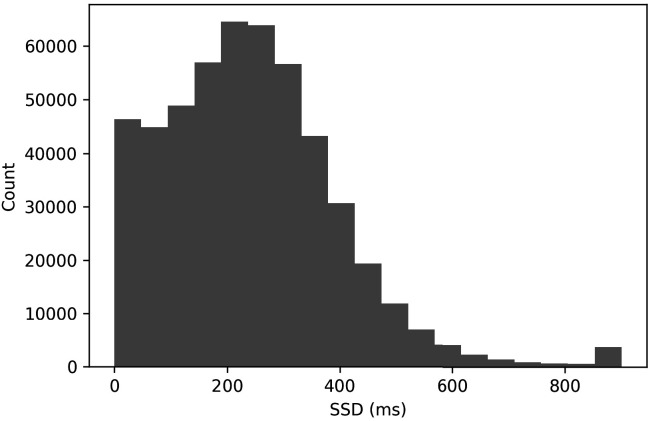
Histogram of stop-signal delays.